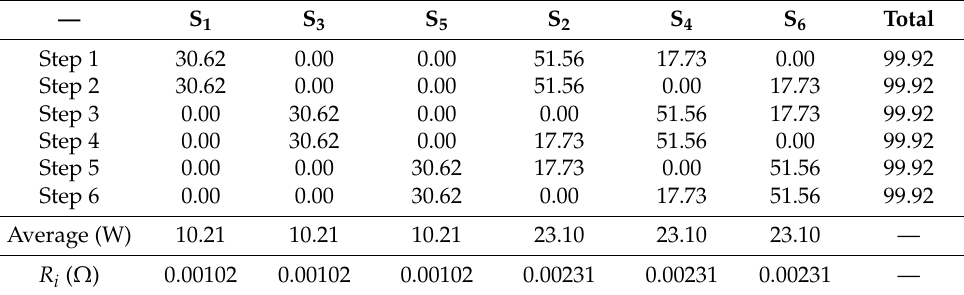
Table 3. Power losses and equivalent resistances of these six inverter switches during one PWM six-step commutation cycle at 25 °C.